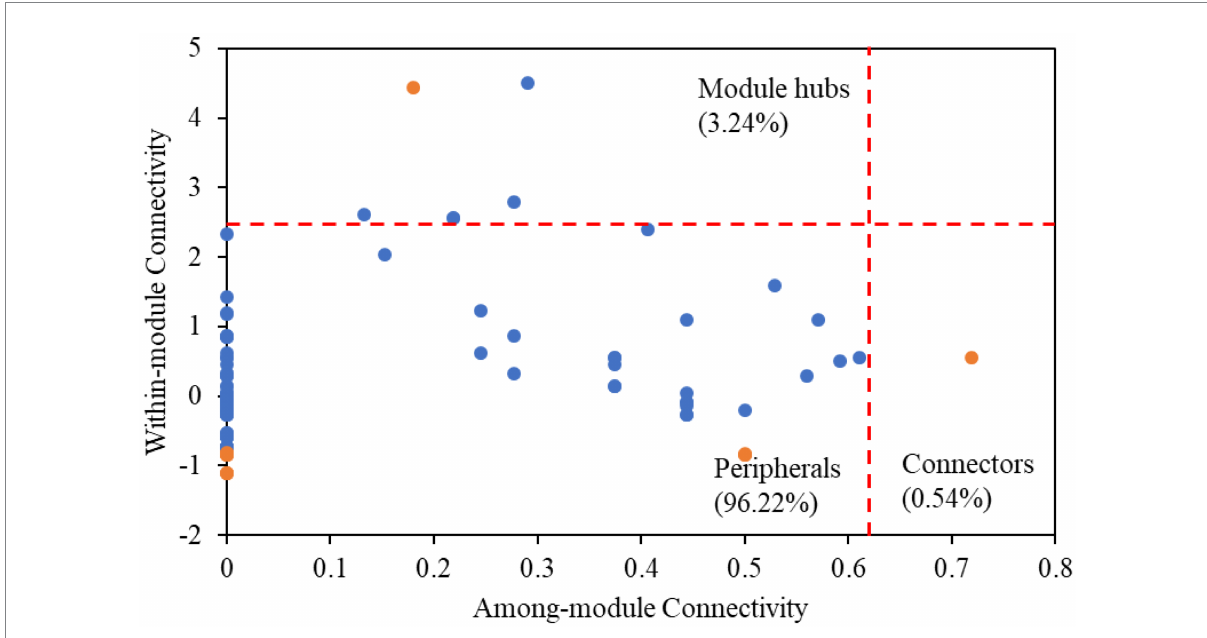
FIGURE 4 The ZP-plots shows distribution of ASVs/OTUs according to their module-based topological roles in the networks of five karst tiankengs. Each blue or orange dot represents a bacterial ASVs or fungal OTUs,